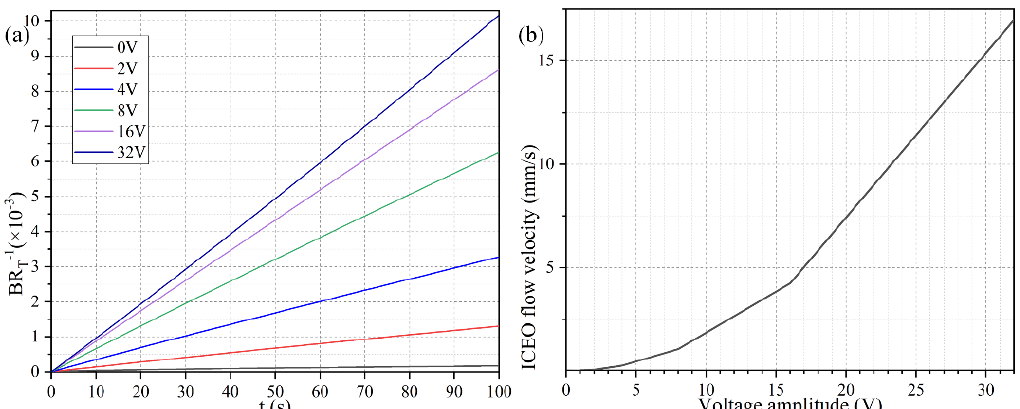
Figure 5. ( a ) Normalized concentration evolution of the bound antigen with respect to the immobilized antibody on the functionalized surface of FE affected by ROT-ICEO under varying AC voltage at f = 200 Hz. ( b ) ROT-ICEO slipping velocity as a function of the applied voltage at f = 200 Hz.